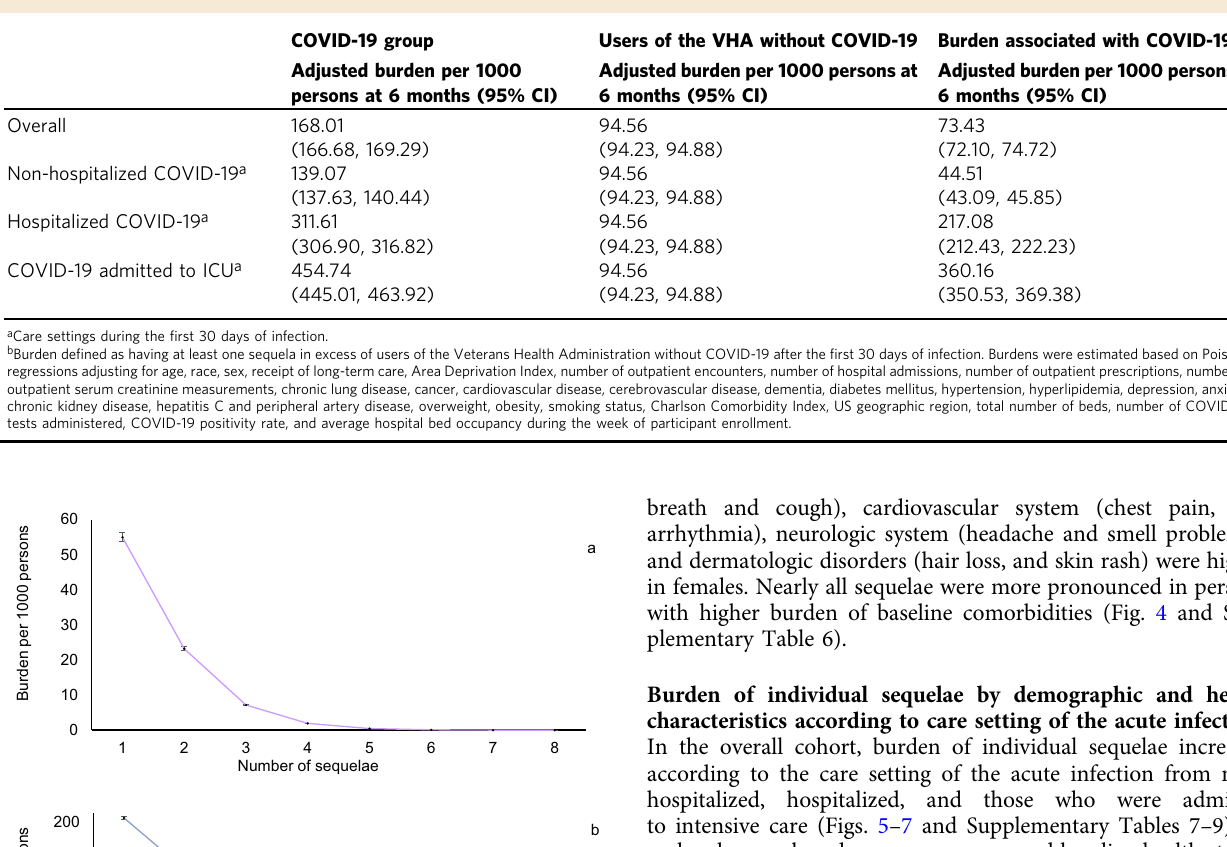
Table 2 Overall burden of post-acute sequelae of SARS-CoV-2 infection (PASC) per 1000 persons at 6 months in the overall cohort and across care setting (non-hospitalized, hospitalized, and admitted to intensive care during the acute phase of the infection).